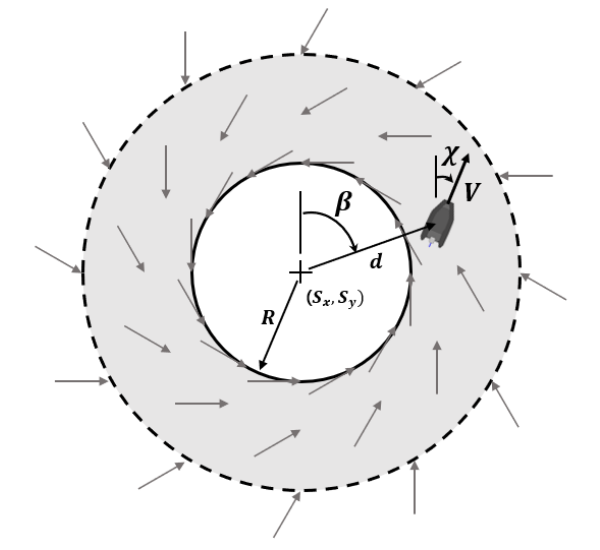
Figure 6. Schematic of the vector field concept for a circular